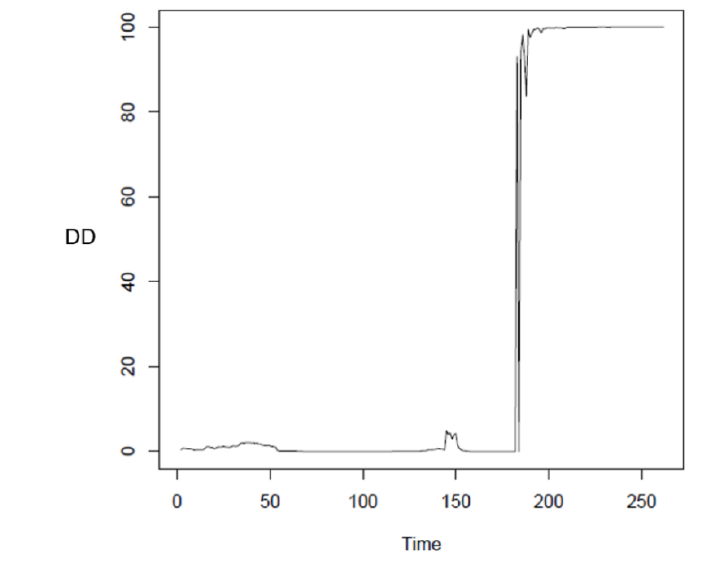
Fig. 2 DD value of listed companies. DD, distance to